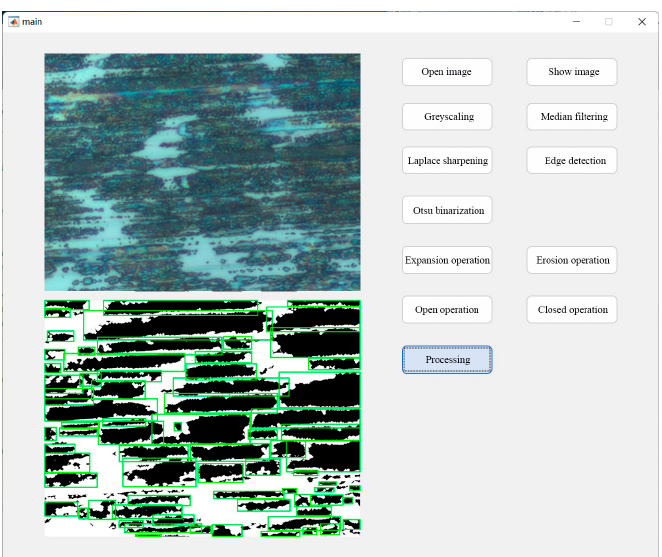
Figure 10. MATLAB program interface for transfer film feature identification and parameter extraction.